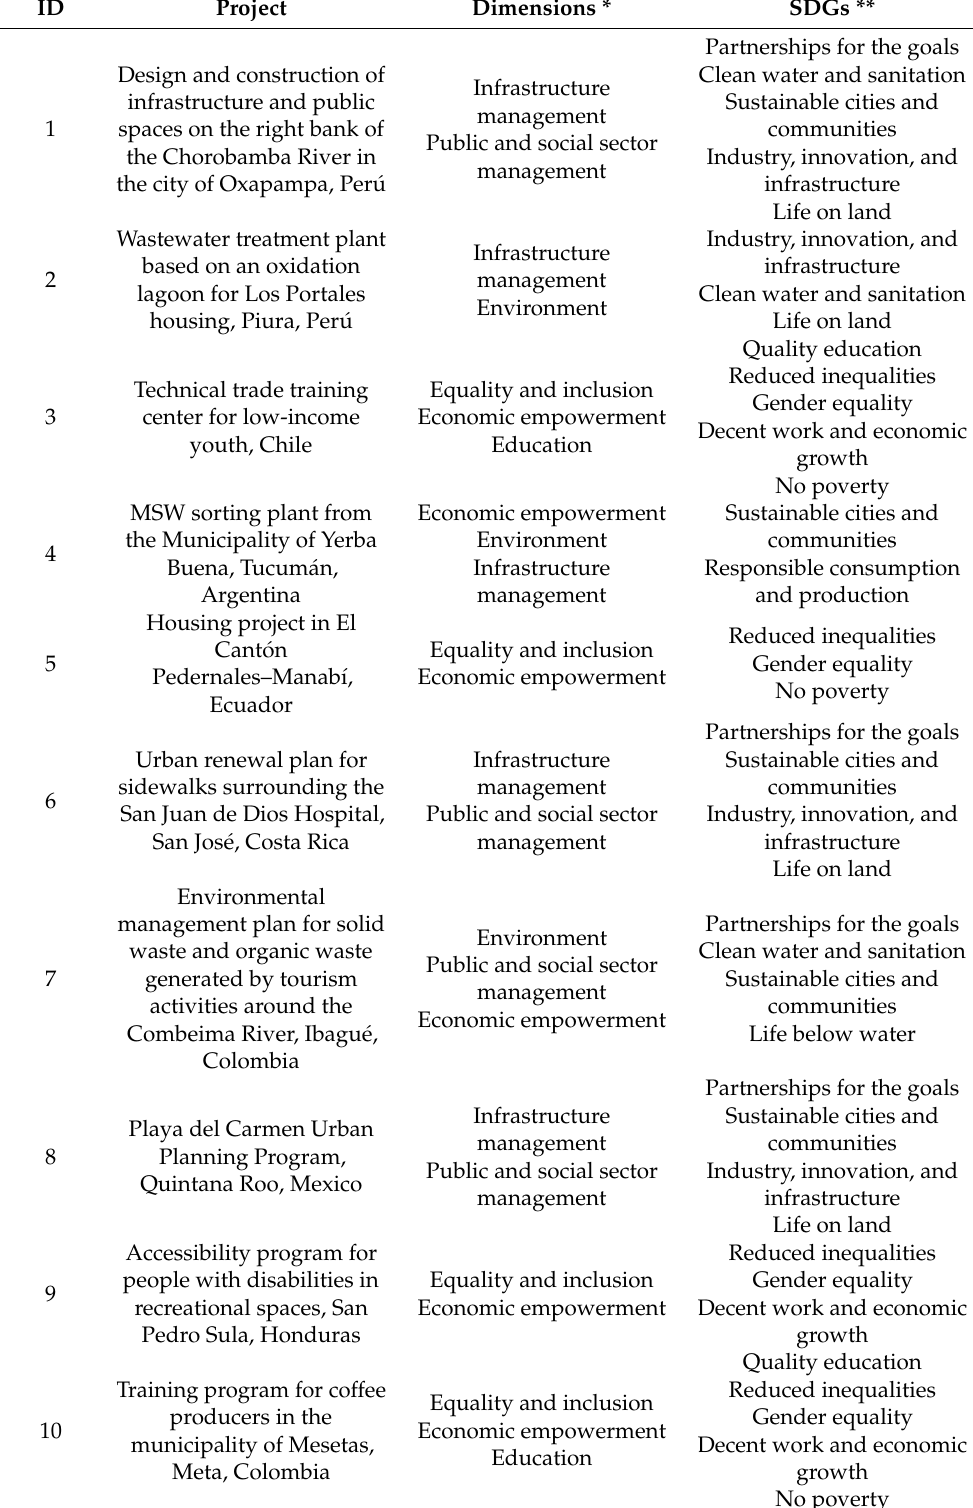
Table 4. Sub-sample list of 10 sustainability projects for local communities in Latin America and the